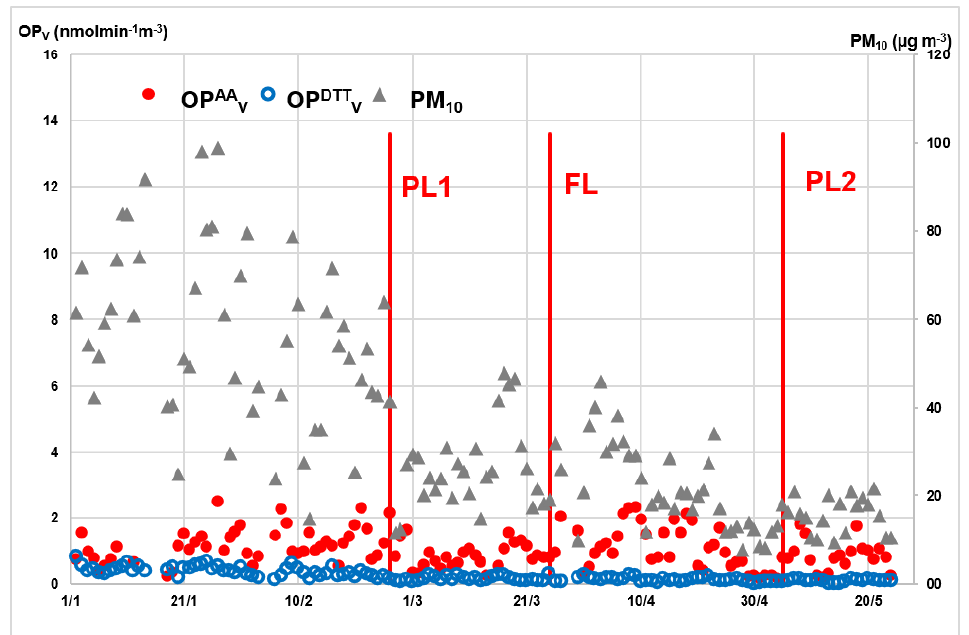
Figure 1. Temporal evolution along the whole investigated time of the extrinsic volume-based OP AA V (red points, left Y scale) and OP DTT V (blue circles, right Y scale) responses and the PM 10 concentrations (grey triangles, right Y scale). The vertical lines indicate the first day of each lockdown period, namely 26 February for PL1, 25 March for FL, and 5 May for PL2. Table 1. OP responses measured with AA and DTT assays, concentrations of atmospheric pollutants (nitrogen dioxide, NO 2 , and black carbon, BC) and of PM 10 chemical components, ambient temper- ature: means and standard deviation values computed for the whole study and each lockdown pe- riod. * indicates significant differences (Student t -test. p ≤ 0.05) between the periods. BLQ = below quantification limit. Total 2 January – 18 May